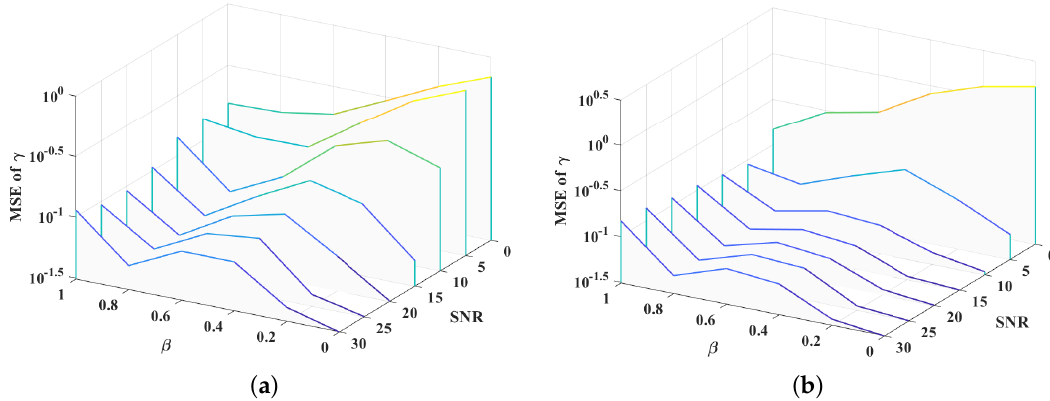
Figure 6. The MSE of the estimated hyperparameter γ by the proposed PB-CSBL and NC-CSCE algorithms under different SNRs and temporal correlation coefficients: ( a ) the PB-CSBL algorithm; and ( b ) the NC-CSCE